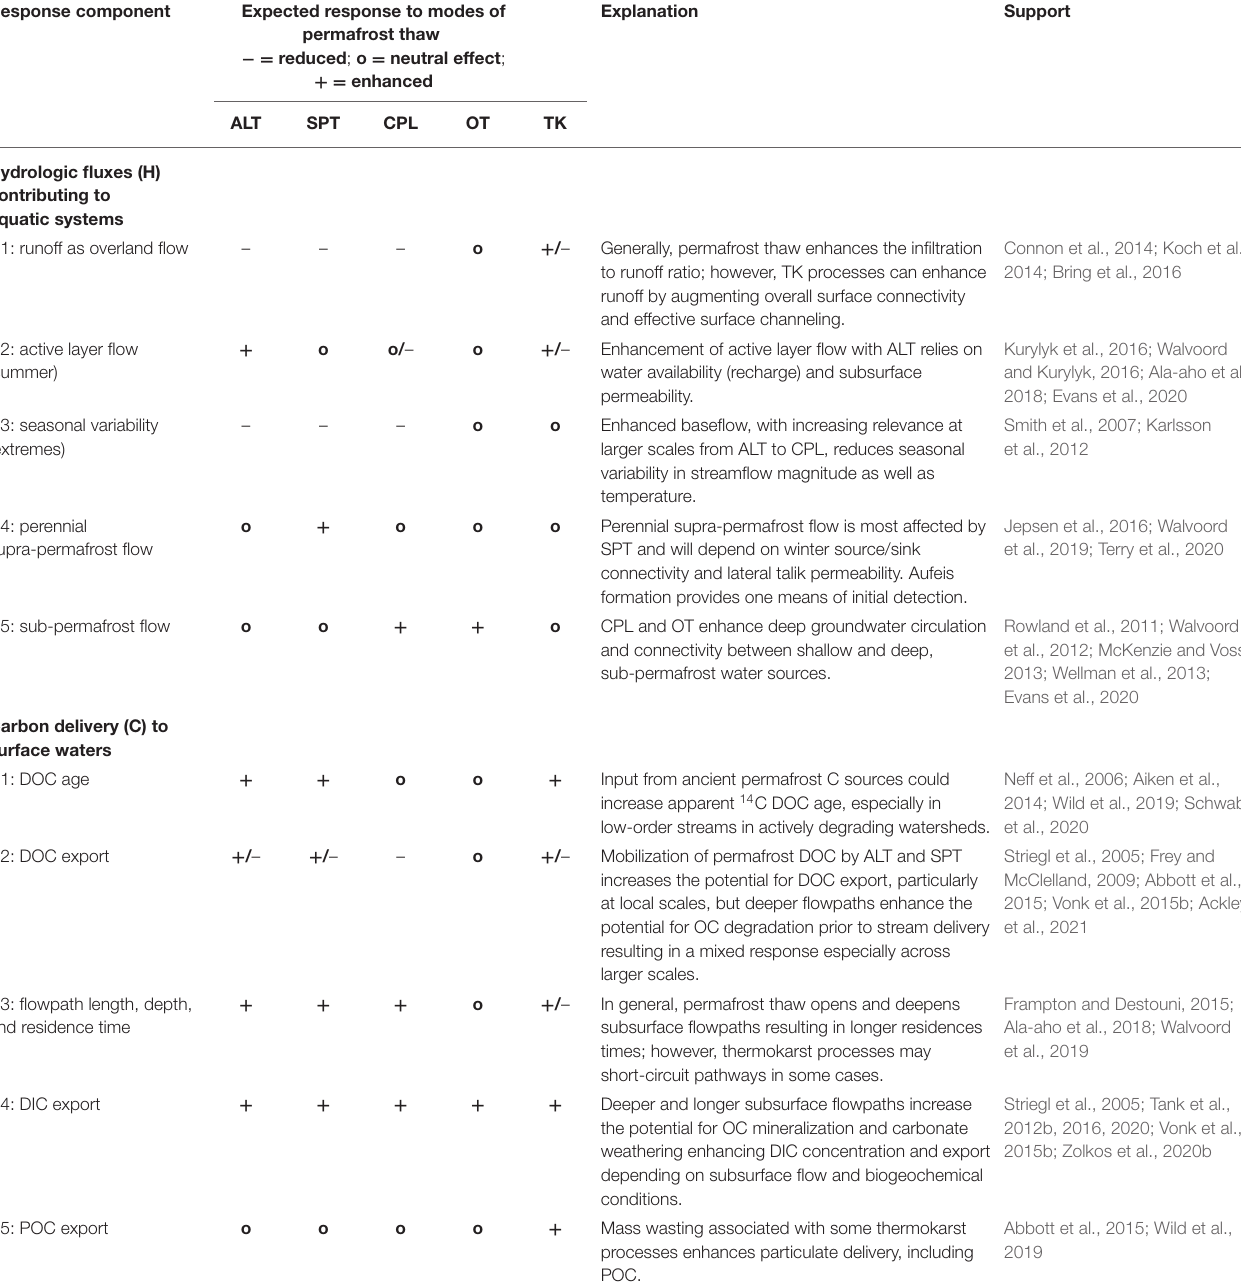
TABLE 2 | Summary of expected hydrologic and aquatic carbon responses to specified modes of permafrost thaw. Response